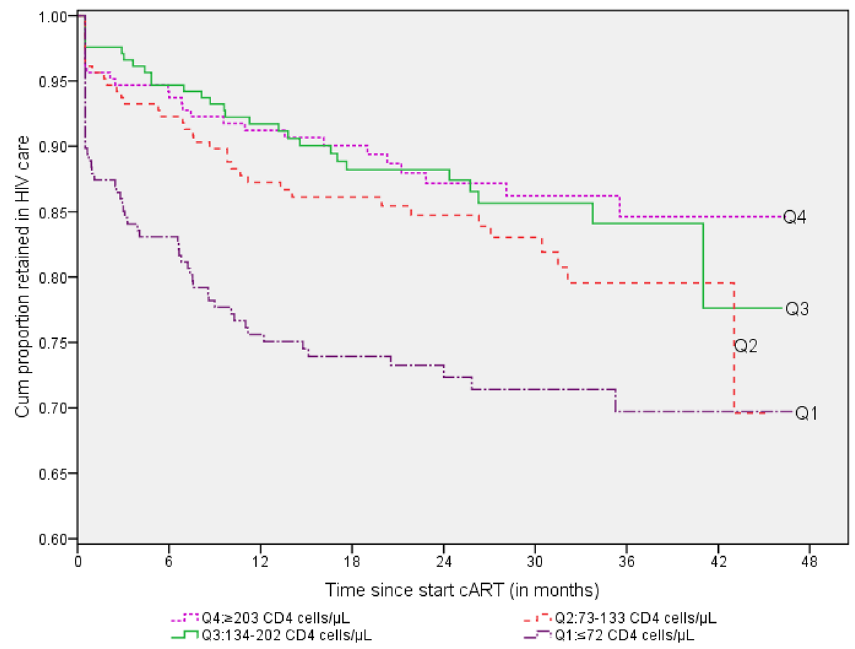
Fig 2. Kaplan-Meier survival curve of retention in HIV care by quartiles of CD4 cell count (cells/ μ L) at the start of cART, Addis Ababa, 2013 (n = 836).